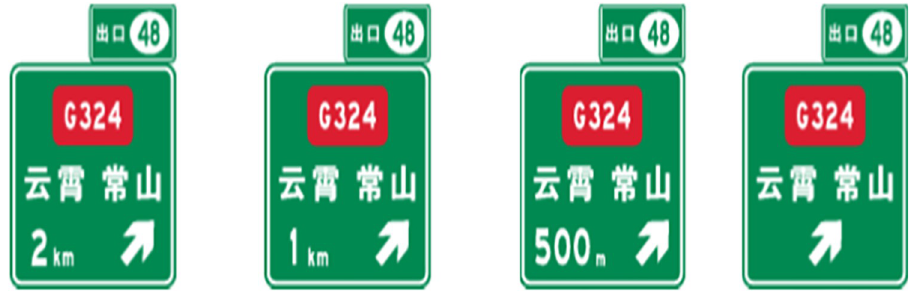
Fig 1. Expressway interchange exit advance guide